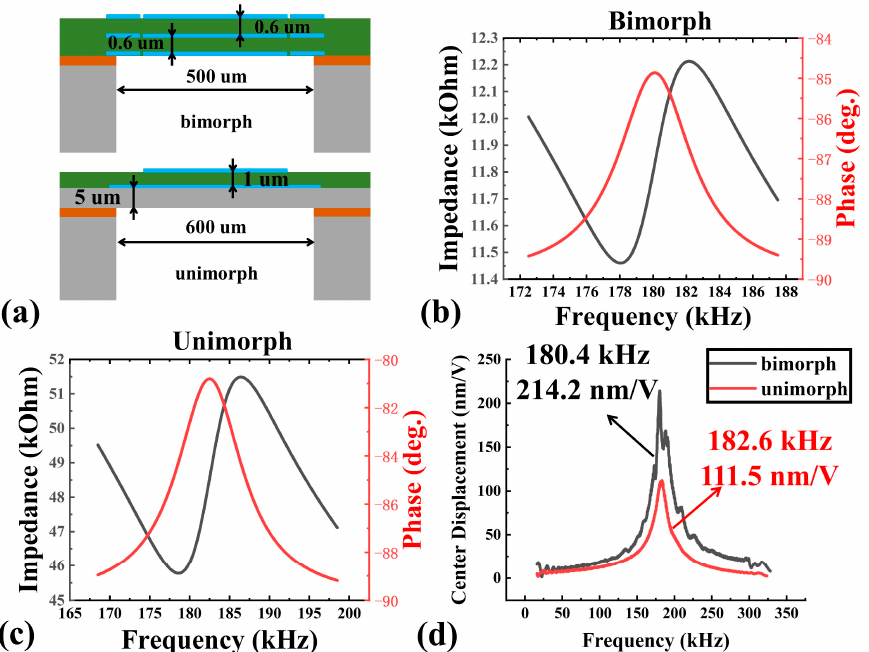
Figure 8. Device characterization for: ( a ) The schematic 2D cross-section drawing of bimorph and unimorph PMUT; ( b ) Electrical impedance characterization for bimorph; ( c ) Electrical impedance characterization for unimorph; ( d ) Dynamic mechanical amplitude characterization for bimorph and unimorph.